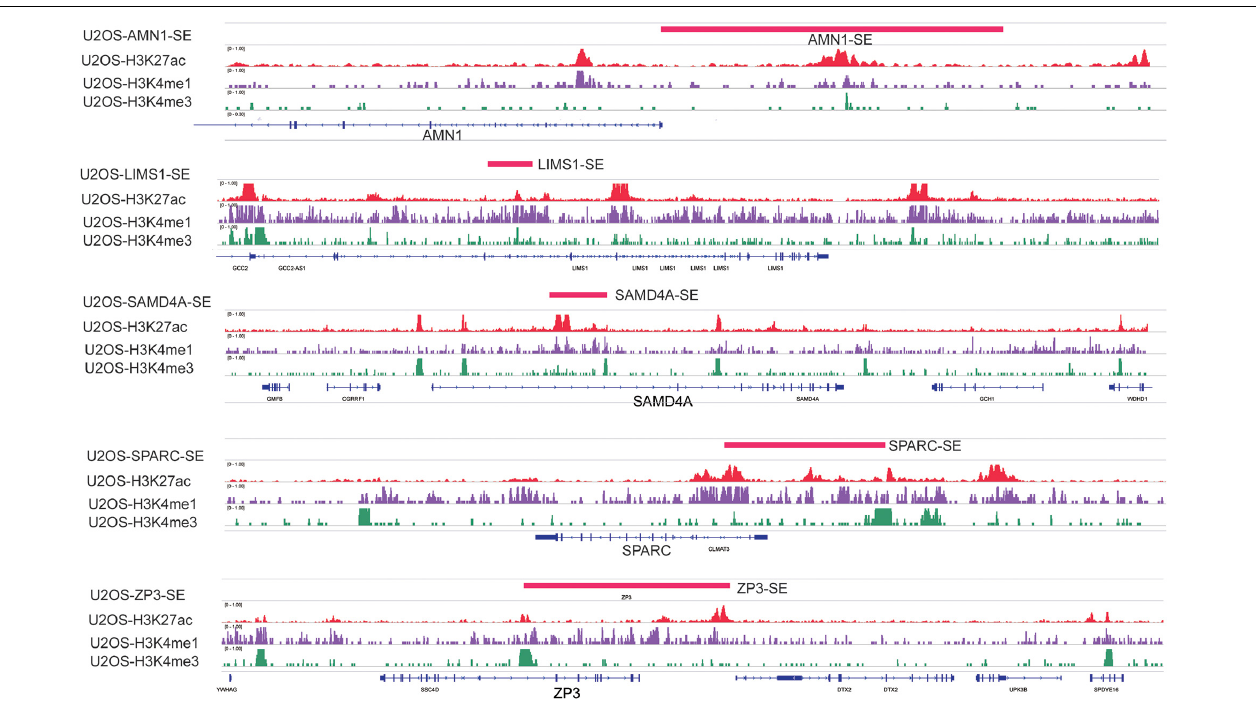
FIGURE 7 | Signal tracks for H3K27ac (red), H3K4me1 (purple), and H3K4me3 (green) ChIP–seq profiles of the five-SE-associated hub genes visualized using IGV. The regions of SE are shown in a pink bar upon the signal tracks. ChIP–seq, chromatin immunoprecipitation–sequencing; SE, super-enhancer; IGV, Integrative Genomics